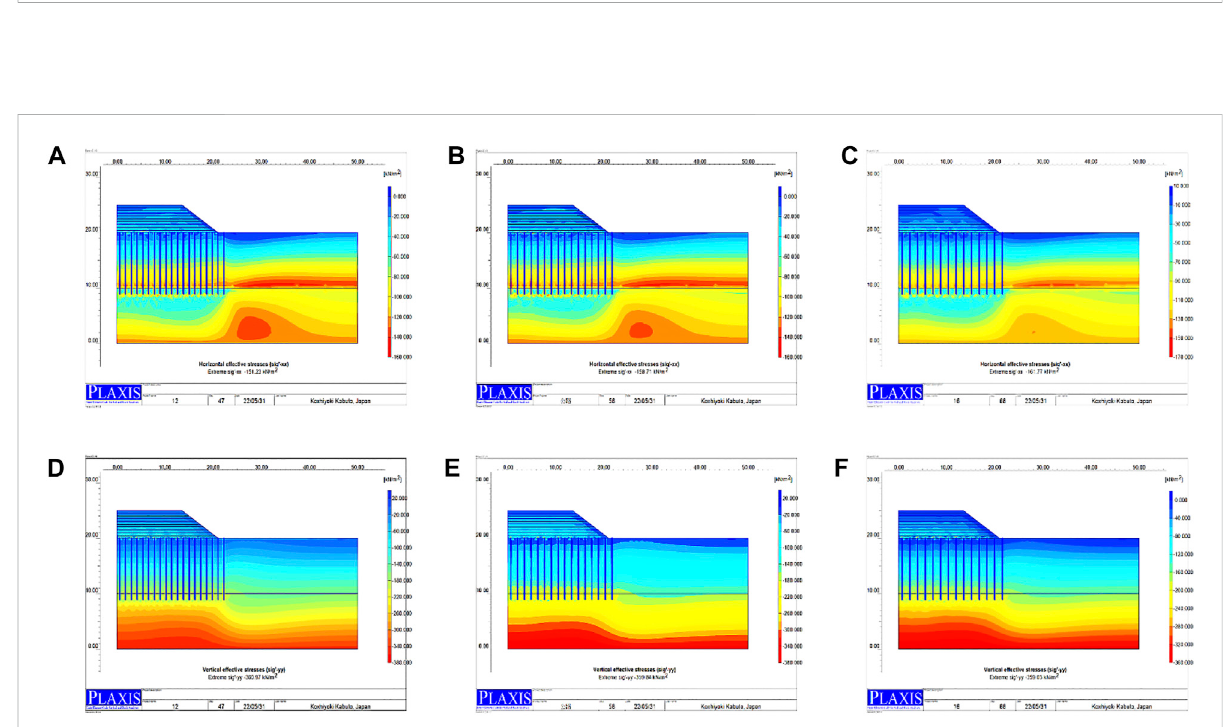
signi fi cant impact on the vertical settlement of the embankment, and the settlement decreased signi fi cantly with the increase in the pile length. The changes in the pile distance had a signi fi cant impact on the horizontal displacement of the embankment, and the horizontal displacement of the soil was reduced with the increase in the horizontal stiffness of the pile distance. The in fl uence